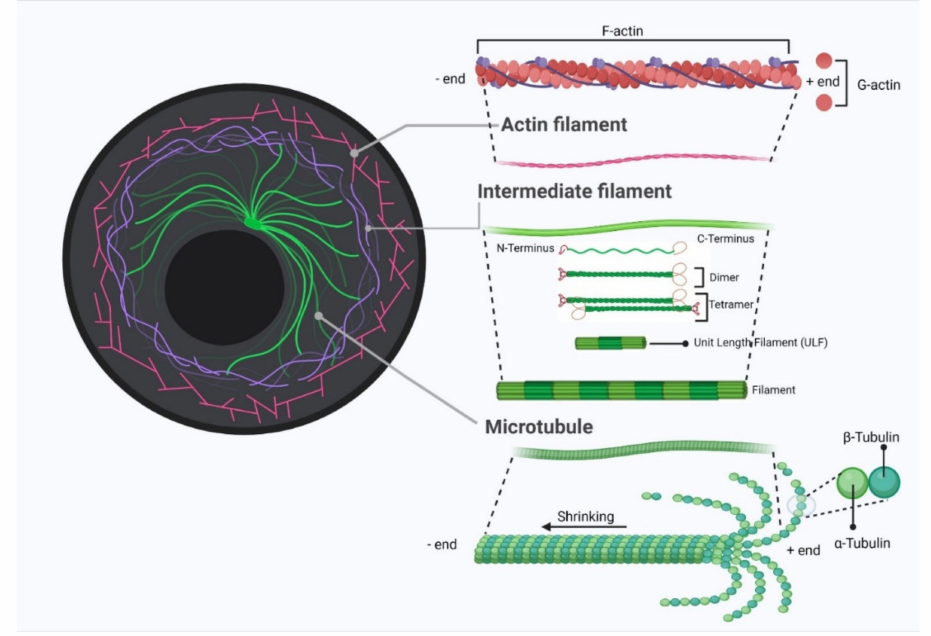
Figure 2. Schematic diagram of cytoskeleton structure that illustrates the three key components: actin filament, microtubule, and intermediate filament. The figure was created with BioRender.com (accessed on 14 February 2022) and was exported under a paid